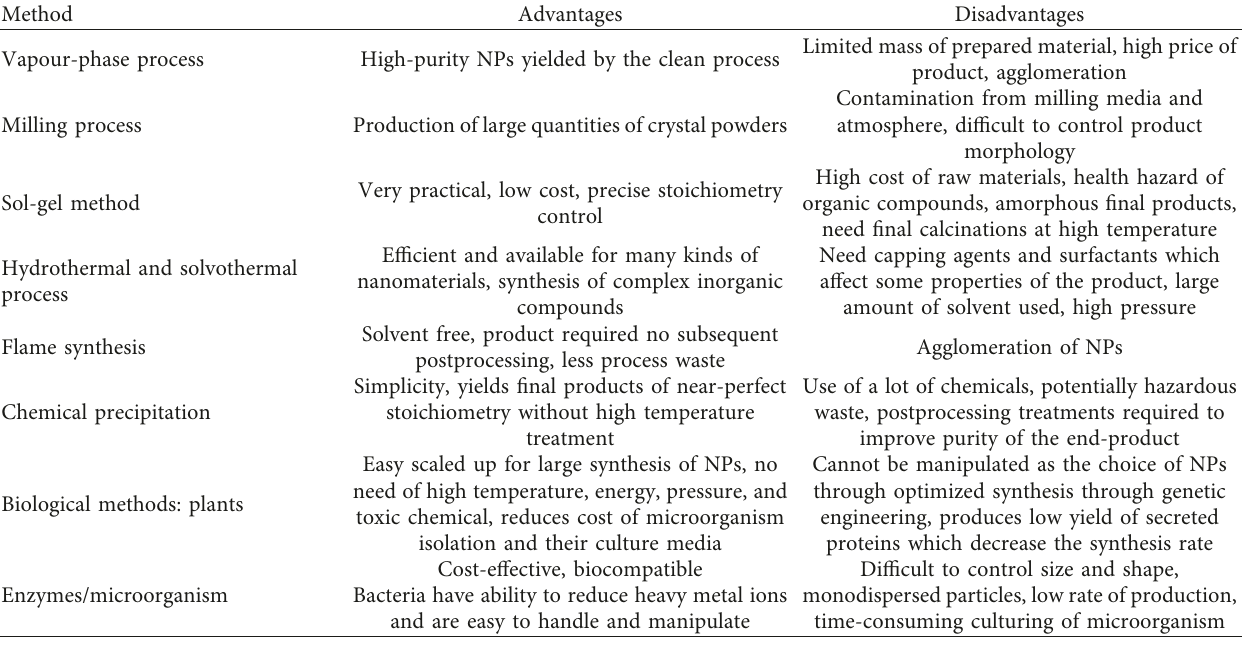
Table 7: Advantages and disadvantages of some methods of preparing NPs.